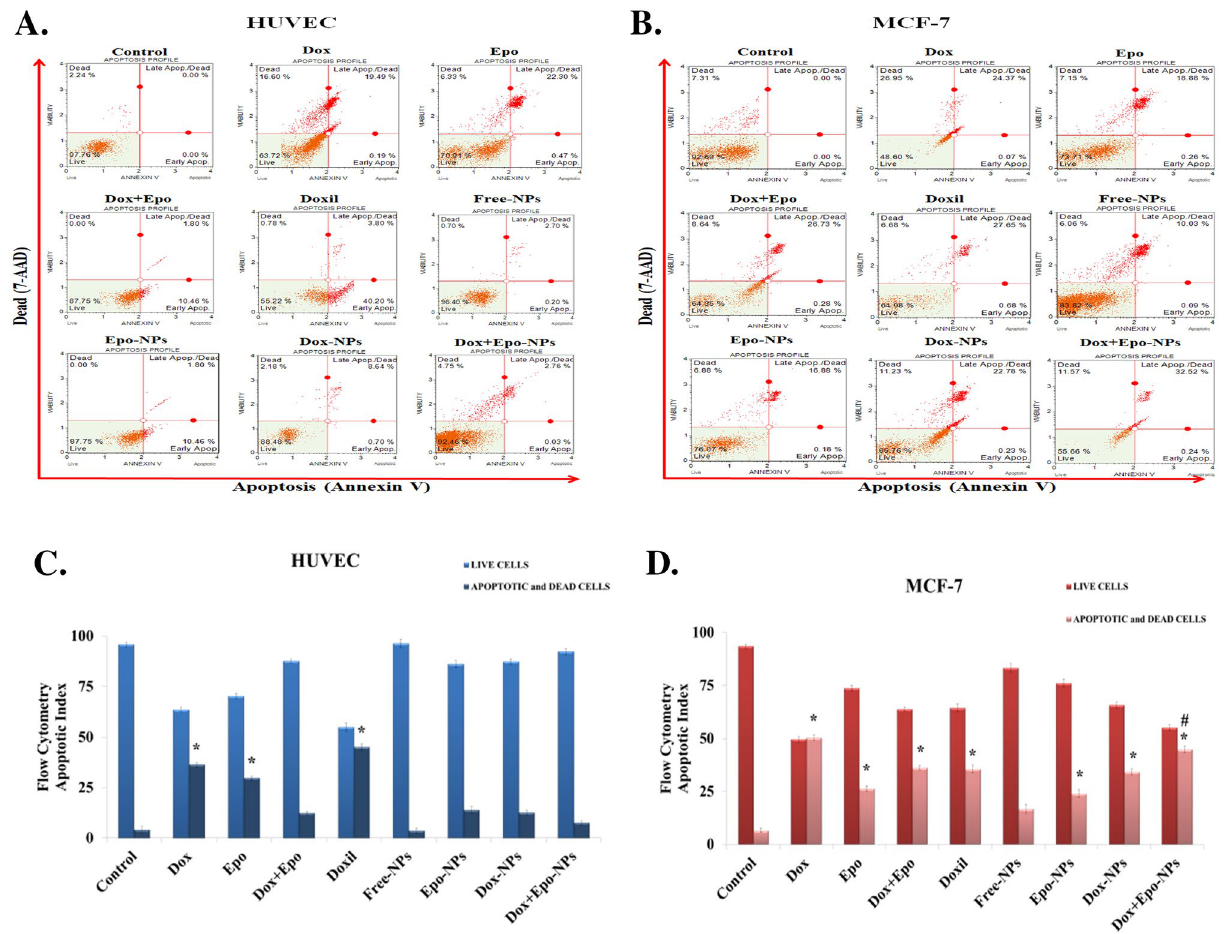
Figure 7. (A) Percentage of survival and apoptotic cells using FC analysis in the nine HUVECs groups incubated for 6 h. Values are mean ± SD, n = 3 measurements of 25.000 cells (n = 3 in each experiment). ( B) Percentage of survival and apoptotic cells using FC analysis in the nine MCF-7 cell groups incubated for 6 h. Values are mean ± SD, n = 3 measurements of 25.000 cells (n = 3 in each experiment). ( C) Percentage of apoptotic index in the nine HUVECs groups incubated for 6 h (n = 3 in each experiment). Values are mean ± SD. *Values significantly different from the control, free Dox + Epo, Free-NPs, Epo-NPs, Dox-NPs, and Dox + Epo-NPs groups in the HUVECs p < 0.001. ( D) Percentage of apoptotic index in the nine MCF-7 cell groups incubated for 6 h (n = 3 in each experiment). Values are mean ± SD. *Values significantly different from the control and Free-NPs groups in the HUVECs p < 0.001. # Values significantly different from control, free Dox, free Epo, free Dox + Epo, Epo-NPs, and Dox-NPs groups in the MCF-7 cells p < Flow cytometric analysis. HUVECs and the MCF-7 cells were analyzed the apoptotic cells by Annexin V-PE and dead cells staining by 7-amino-actinomycin D (7-AAD). We observed that both HUVECs and MCF-7 cells were killed with free Dox and/or Epo induced apoptosis. We found that apoptosis was statistically reduced in the groups which was encapsulated with Dox and/or Epo to the NPs in the HUVECs (Fig. 7A,C). Thus, encapsulation of drugs into nanoparticles eliminated drug toxicity and prevented normal cells from apoptosis. Apoptotic index increased in Dox + Epo-NPs group compared to the free Dox and Epo combined group in the MCF-7 cells (Fig. 7B,D). While the apoptotic index was around 8% in HUVECs, this rate increased to 45% in MCF-7 cells. Flow cytometry data showed that the MCF-7 cells could not escape from apoptosis and they died in the Dox + Epo-NPs group, while HUVECs remained alive in the same group. TUNEL analysis.